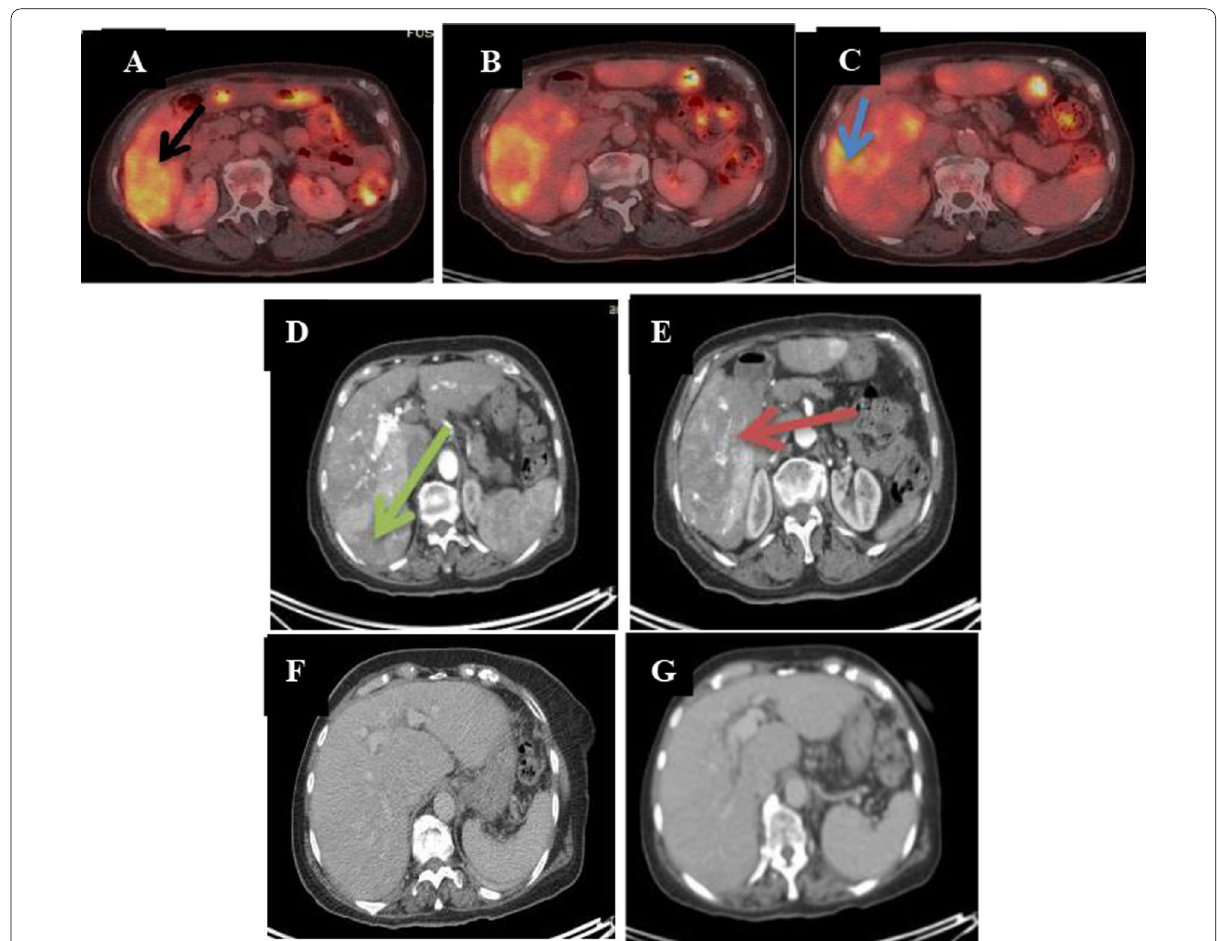
Fig. 4 69 years old female patient suffering from yellow skin and eyes. The US was done showing multiple CFLs. triphasic C/T was done showing multiple HFLs with criteria of HCC, PET/CT was done showing two right lobar metabolically active lesions, no distant metastases. A , B , C , H , I 18F FDG PET/CT images showing the First metabolically active lesion at segment VIII (blue arrow) measuring about 3 another Second metabolically active lesion at segment VI (black arrow) measuring about 8 showing multiple metabolically active HFLs. D , E This lesion in triphasic CT (red arrow) shows early arterial heterogeneous enhancement. F , G the lesion showed rapid washout in Porto venous and delayed